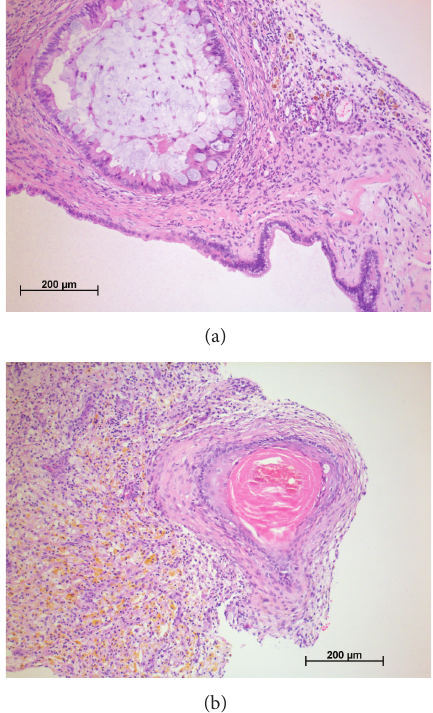
Figure 5: Pathology mature